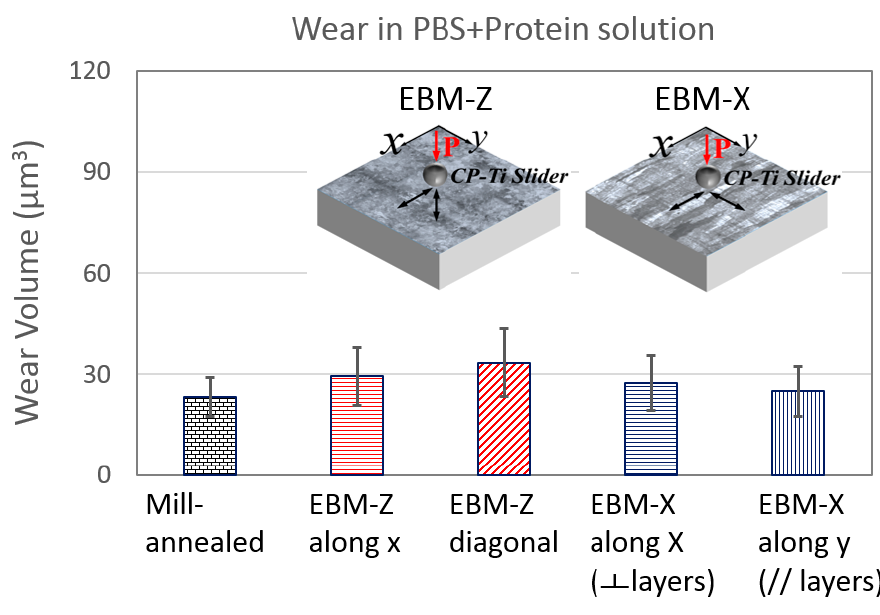
Figure 8. Fatigue-wear damage in simulated synovial fluid.